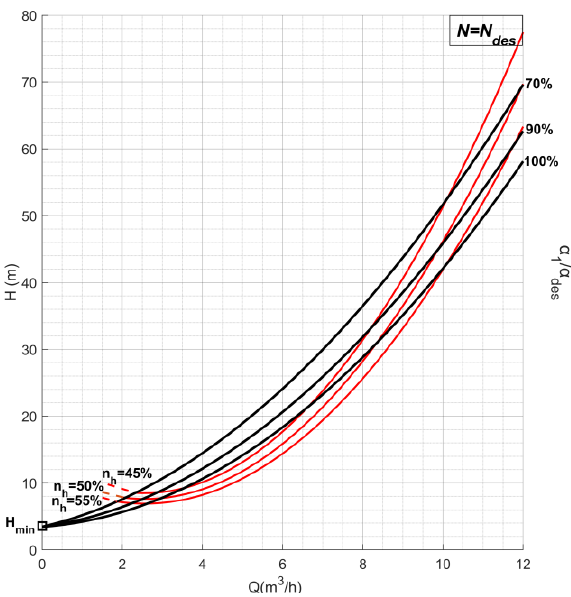
Figure 14. Turbine constant speed performance curves as a function of water flow rate and angle α 1 values for the case of GPV-4.